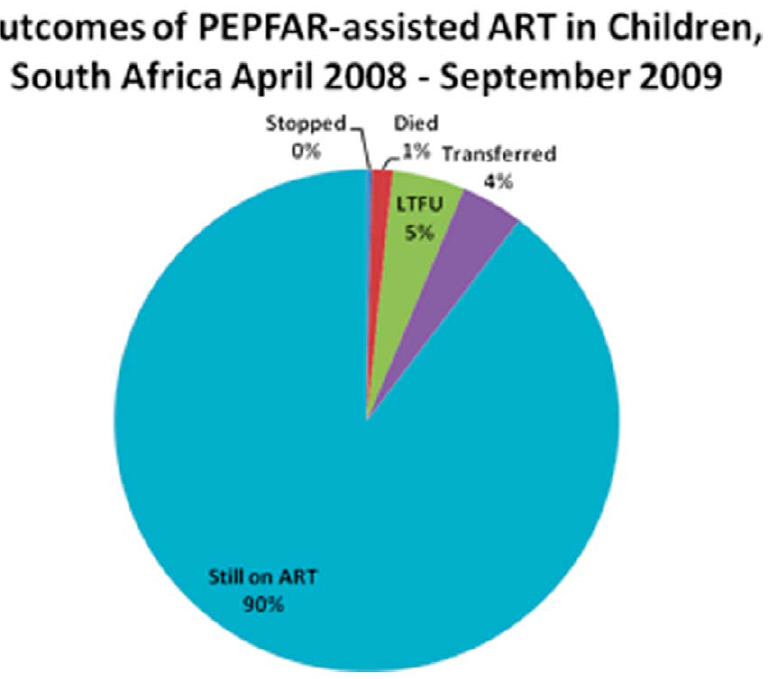
Figure 4. Outcomes of PEPFAR-assisted Antiretroviral Therapy (ART) in Children, South Africa 2008–2009. *Lost to Follow-up (LTFU).